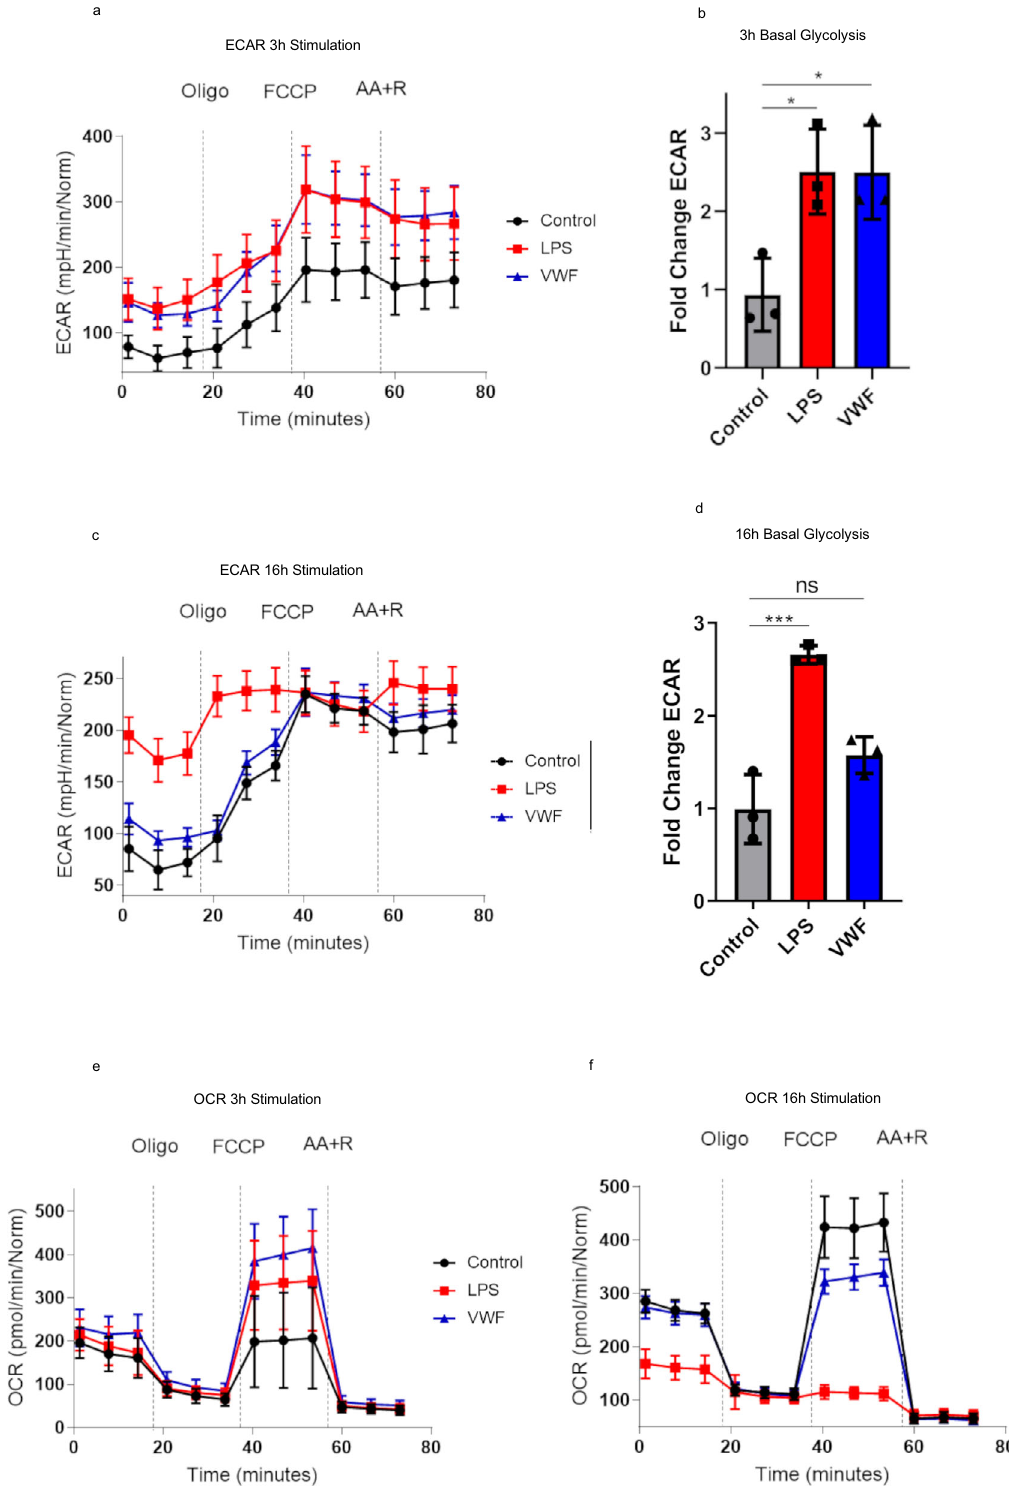
Fig. 5 | VWF regulates macrophage metabolism and drives glycolysis. Extra- cellular fl uxanalysis(SeahorseXFCellMitoStresskit)wasusedtoassesstheeffects of VWF-binding upon macrophage metabolism. Extracellular acidi fi cation (ECAR) was measured to study the effects on glycolysis following stimulation with VWF (10 μ g/ml) (blue), LPS (100ng/ml) (red), or untreated controls (black) for 3h ( a , b ) and 16h ( c , d ) respectively. Similarly, cellular oxygen consumption rate (OCR) was assayedtostudytheeffectsonBMDMoxidativephosphorylationafter3hand16h ( e , f )incubations.TheeffectsofVWFandLPSonBMDMglycolysis(* P =0.0272and